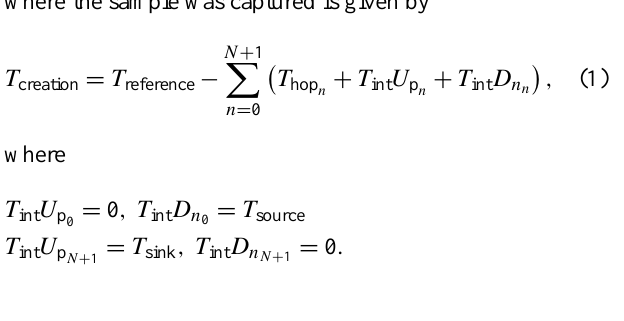
Fig. 5: Successful packet transmission in 802 . 11 networks